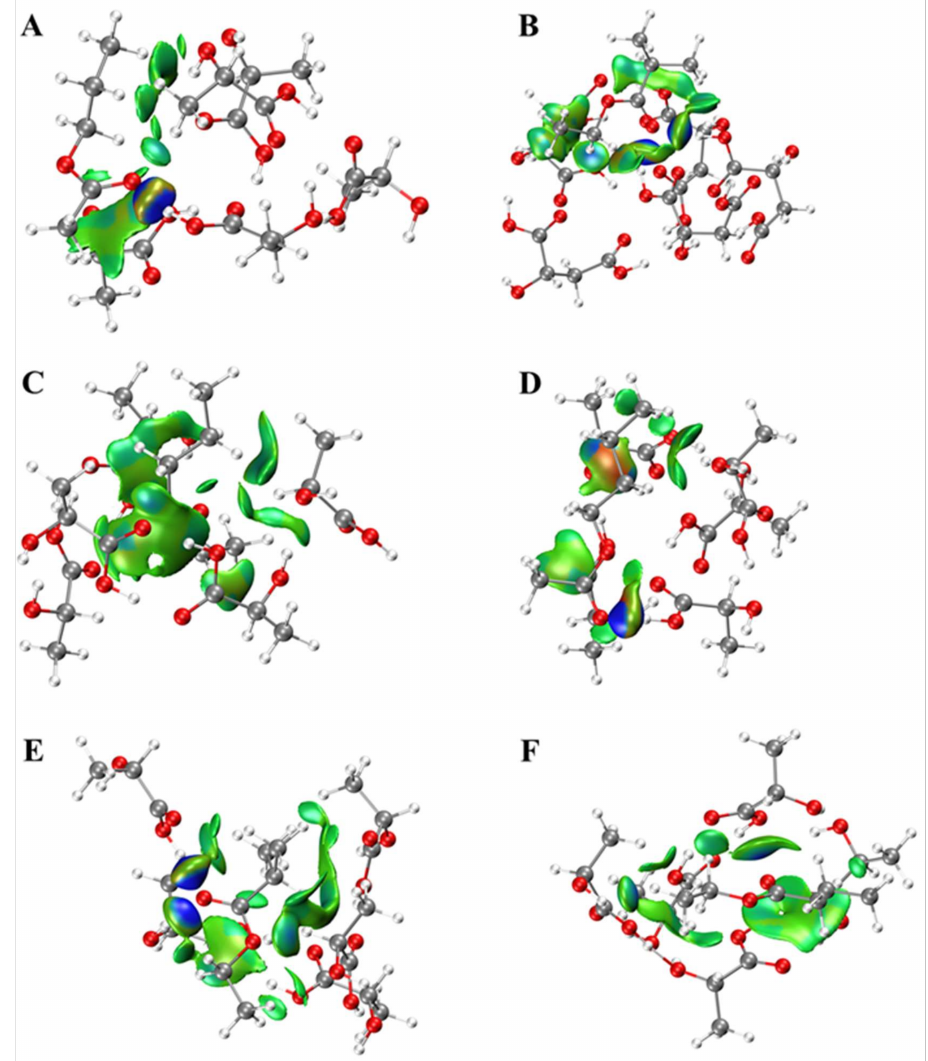
Figure 3. Weak interactions between esters and lactic acid. ( A ) C2C3, ( B ) 2MeC3C2, ( C ) C4C2, ( D ) C2C4, ( E ) 3MeC4C2, ( F ) C5C2, H-white, C-gray,